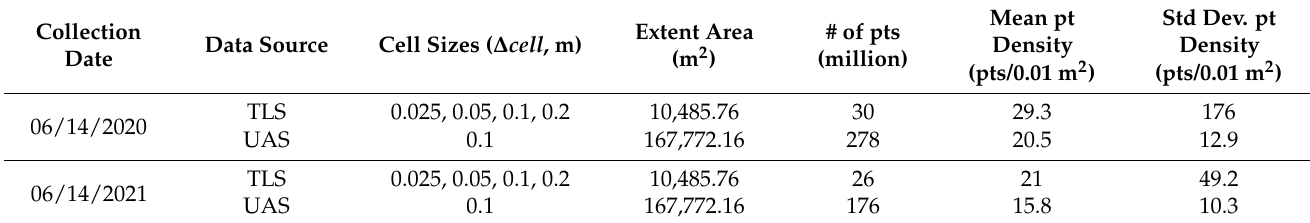
Table 2. Summary table describing each of the DEM rasters included in the test dataset.